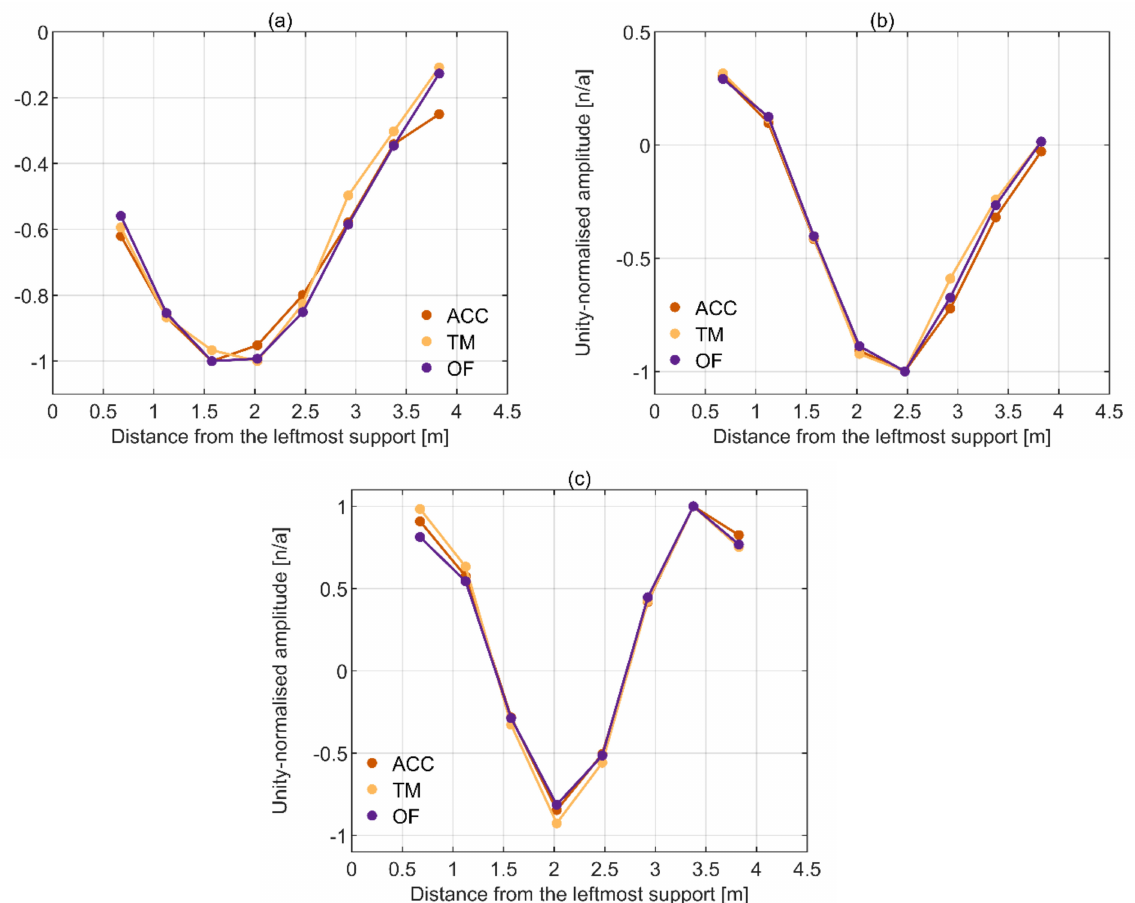
Figure 13. Partial mode shapes for T2: ( a ) mode 1, ( b ) mode 3 and ( c ) mode 4.